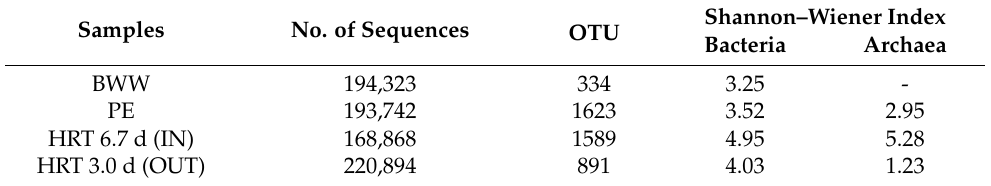
Table 5. Sequencing summary and microbial community (bacteria and archaea) diversity index of